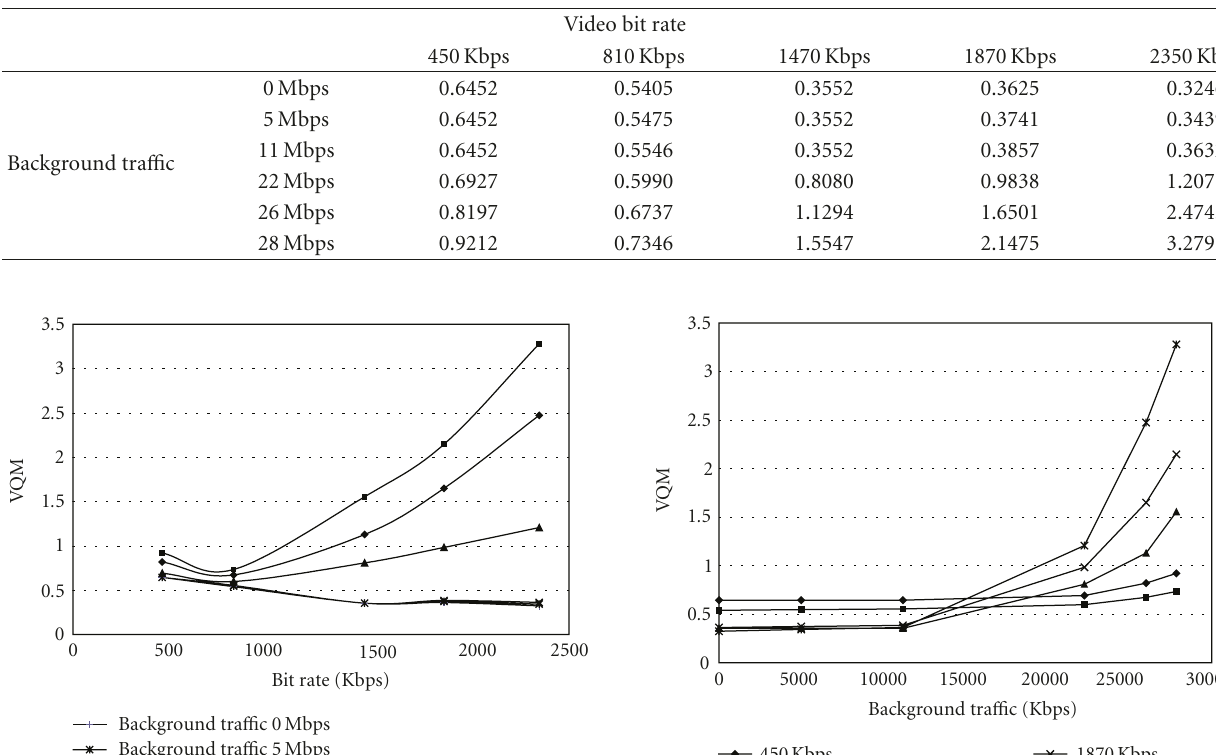
Table 3: System tra ffi c parameters.